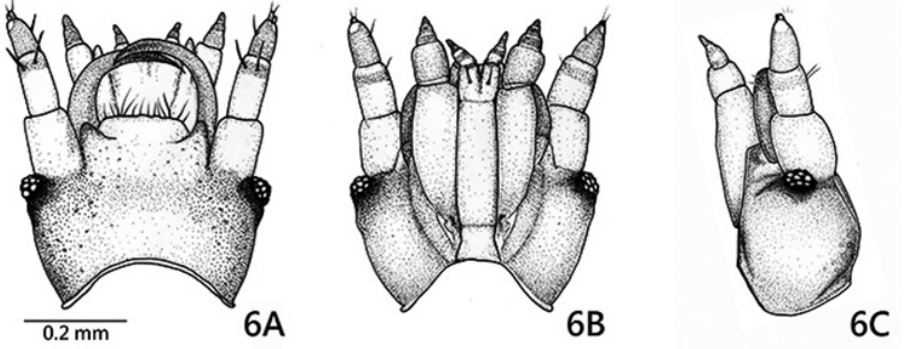
Figure 6. Oculogryphus chenghoiyanae sp. n. female, head, dorsal ( A ), ventral ( B ) and left side ( C )